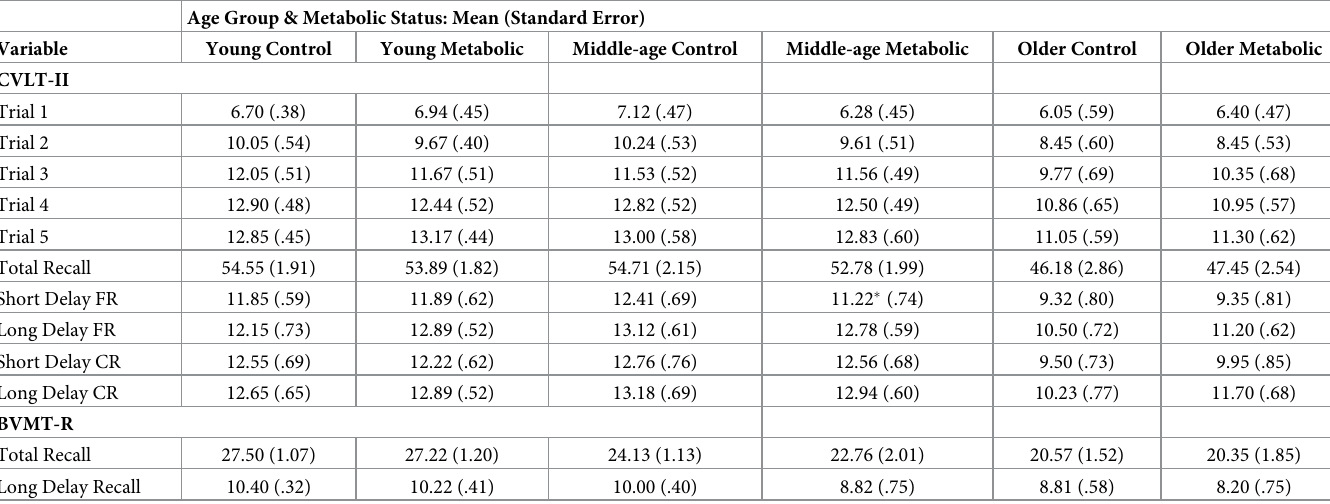
Table 9. Relationship between age, metabolic status, learning and memory. Age Group & Metabolic Status: Mean (Standard